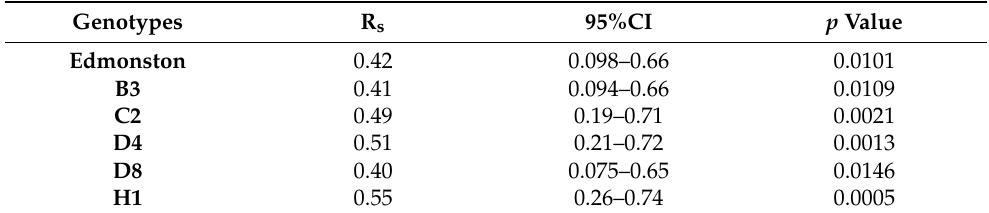
Table 2. Spearman’s rank correlation coefficient between IgG levels (measured by kit from LIAISON ® ) and neutralising antibody titres in Sheffield HCWs.